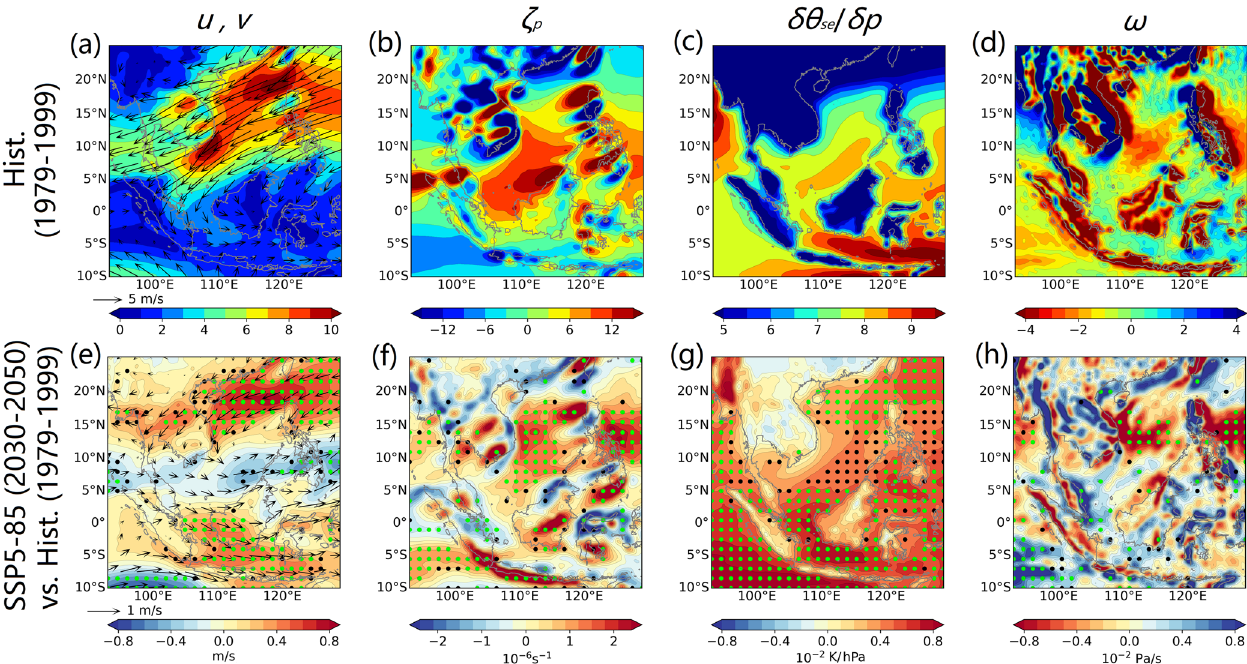
Fig. 4 Changes to the low-tropospheric (925-Pa) environmental fi elds associated with BVs during ONDJFM. a , e The seasonal mean wind fi eld ( u, v ). b , f Relative vorticity ( ζ p ). c , g Moist static instability (i.e. the vertical gradient of pseudo-equivalent potential temperature, d , h Vertical velocity ( ω ). a – d Ensemble mean of historical simulations (1979 – 1999). e – h Ensemble mean of the projected absolute changes for SSP5-85 (2030 – 2050) relative to the historical period. Stippling indicates statistical signi fi cance at con fi dence levels of above 90% (black) and 95%